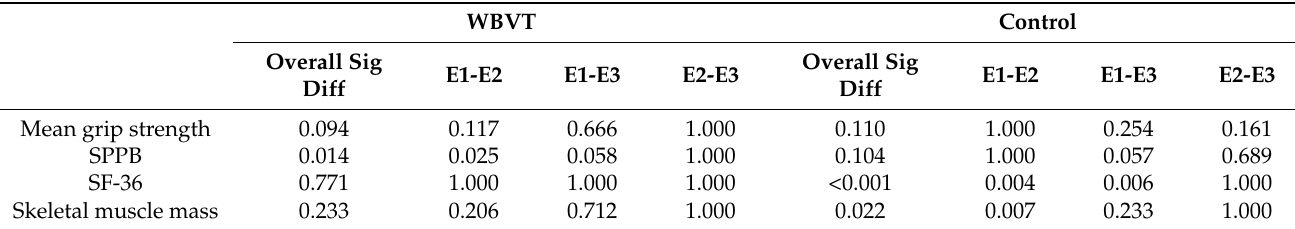
Table 5. Intra-group comparison and post hoc analysis of secondary outcome